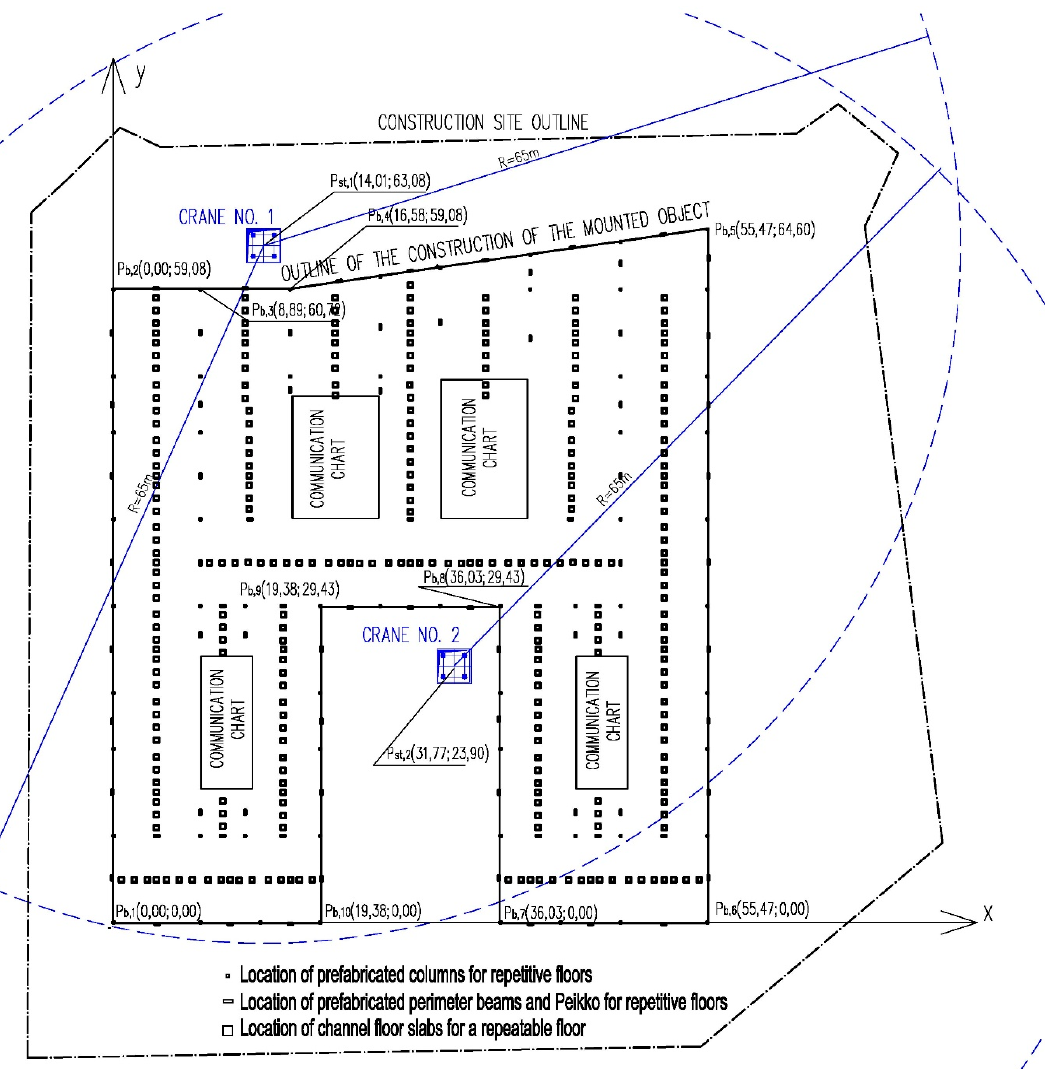
Figure 5. The organizational layout of assembly works the actual way of carrying out assembly works at the “Green2Day” facility.